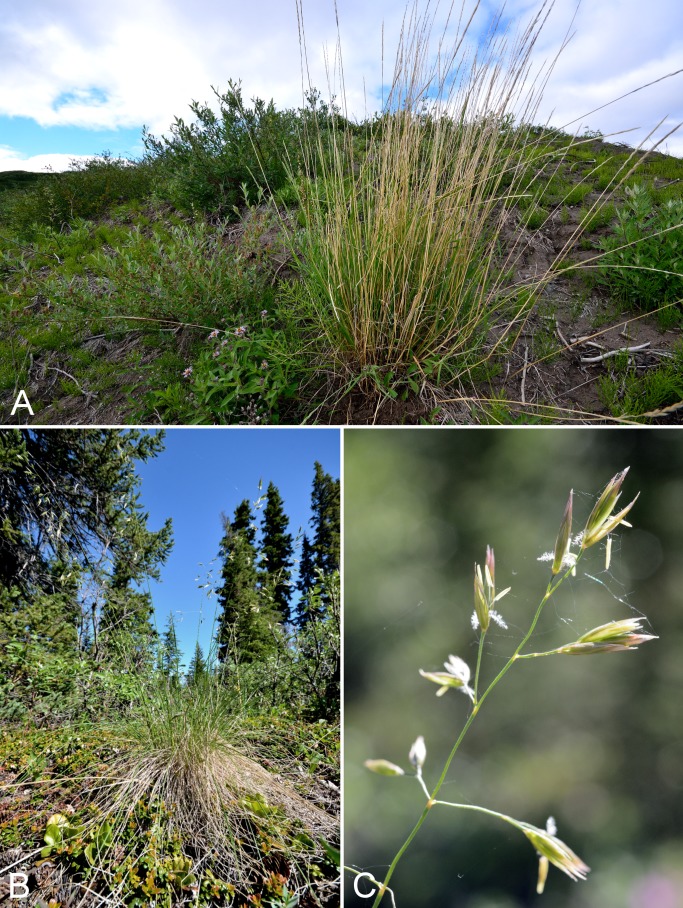
Elymus violaceus and Festuca altaica.Elymus violaceus: (A) habit, Saarela et al. 4138. Festuca altaica: (B) habit, Saarela et al. 3194. (C) Inflorescence, Saarela et al. 3194. Photographs by R. D. Bull.